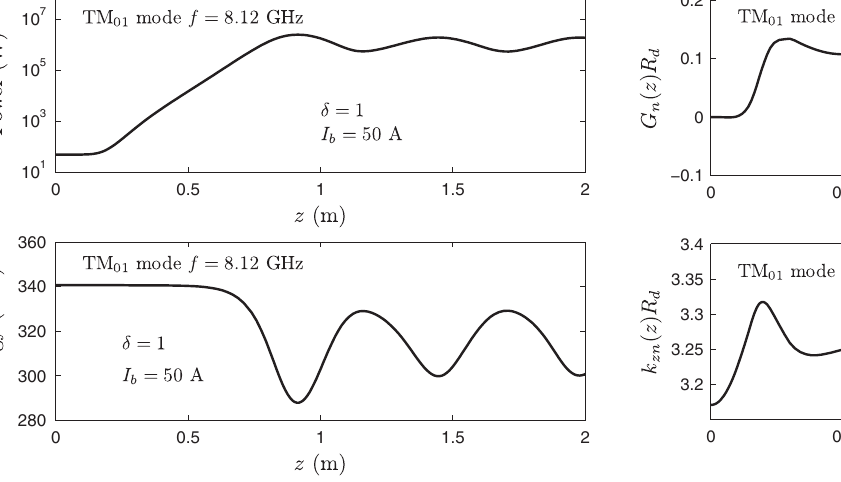
FIG. 8. TM 01 instantaneous normalized growth rate and wave number at 8.12 GHz.